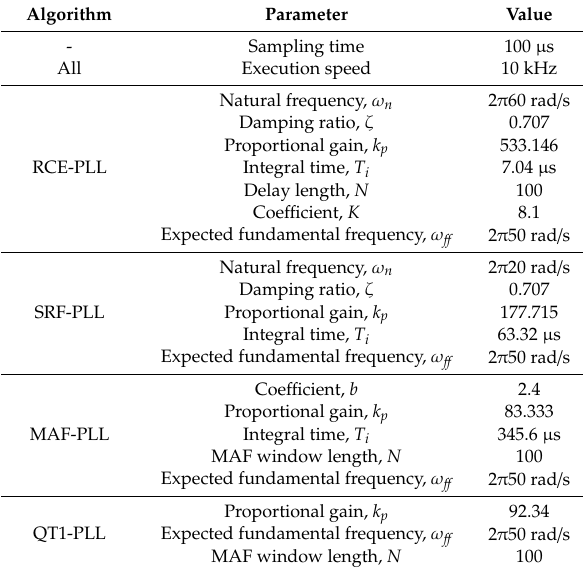
Table 2. Details of the implemented